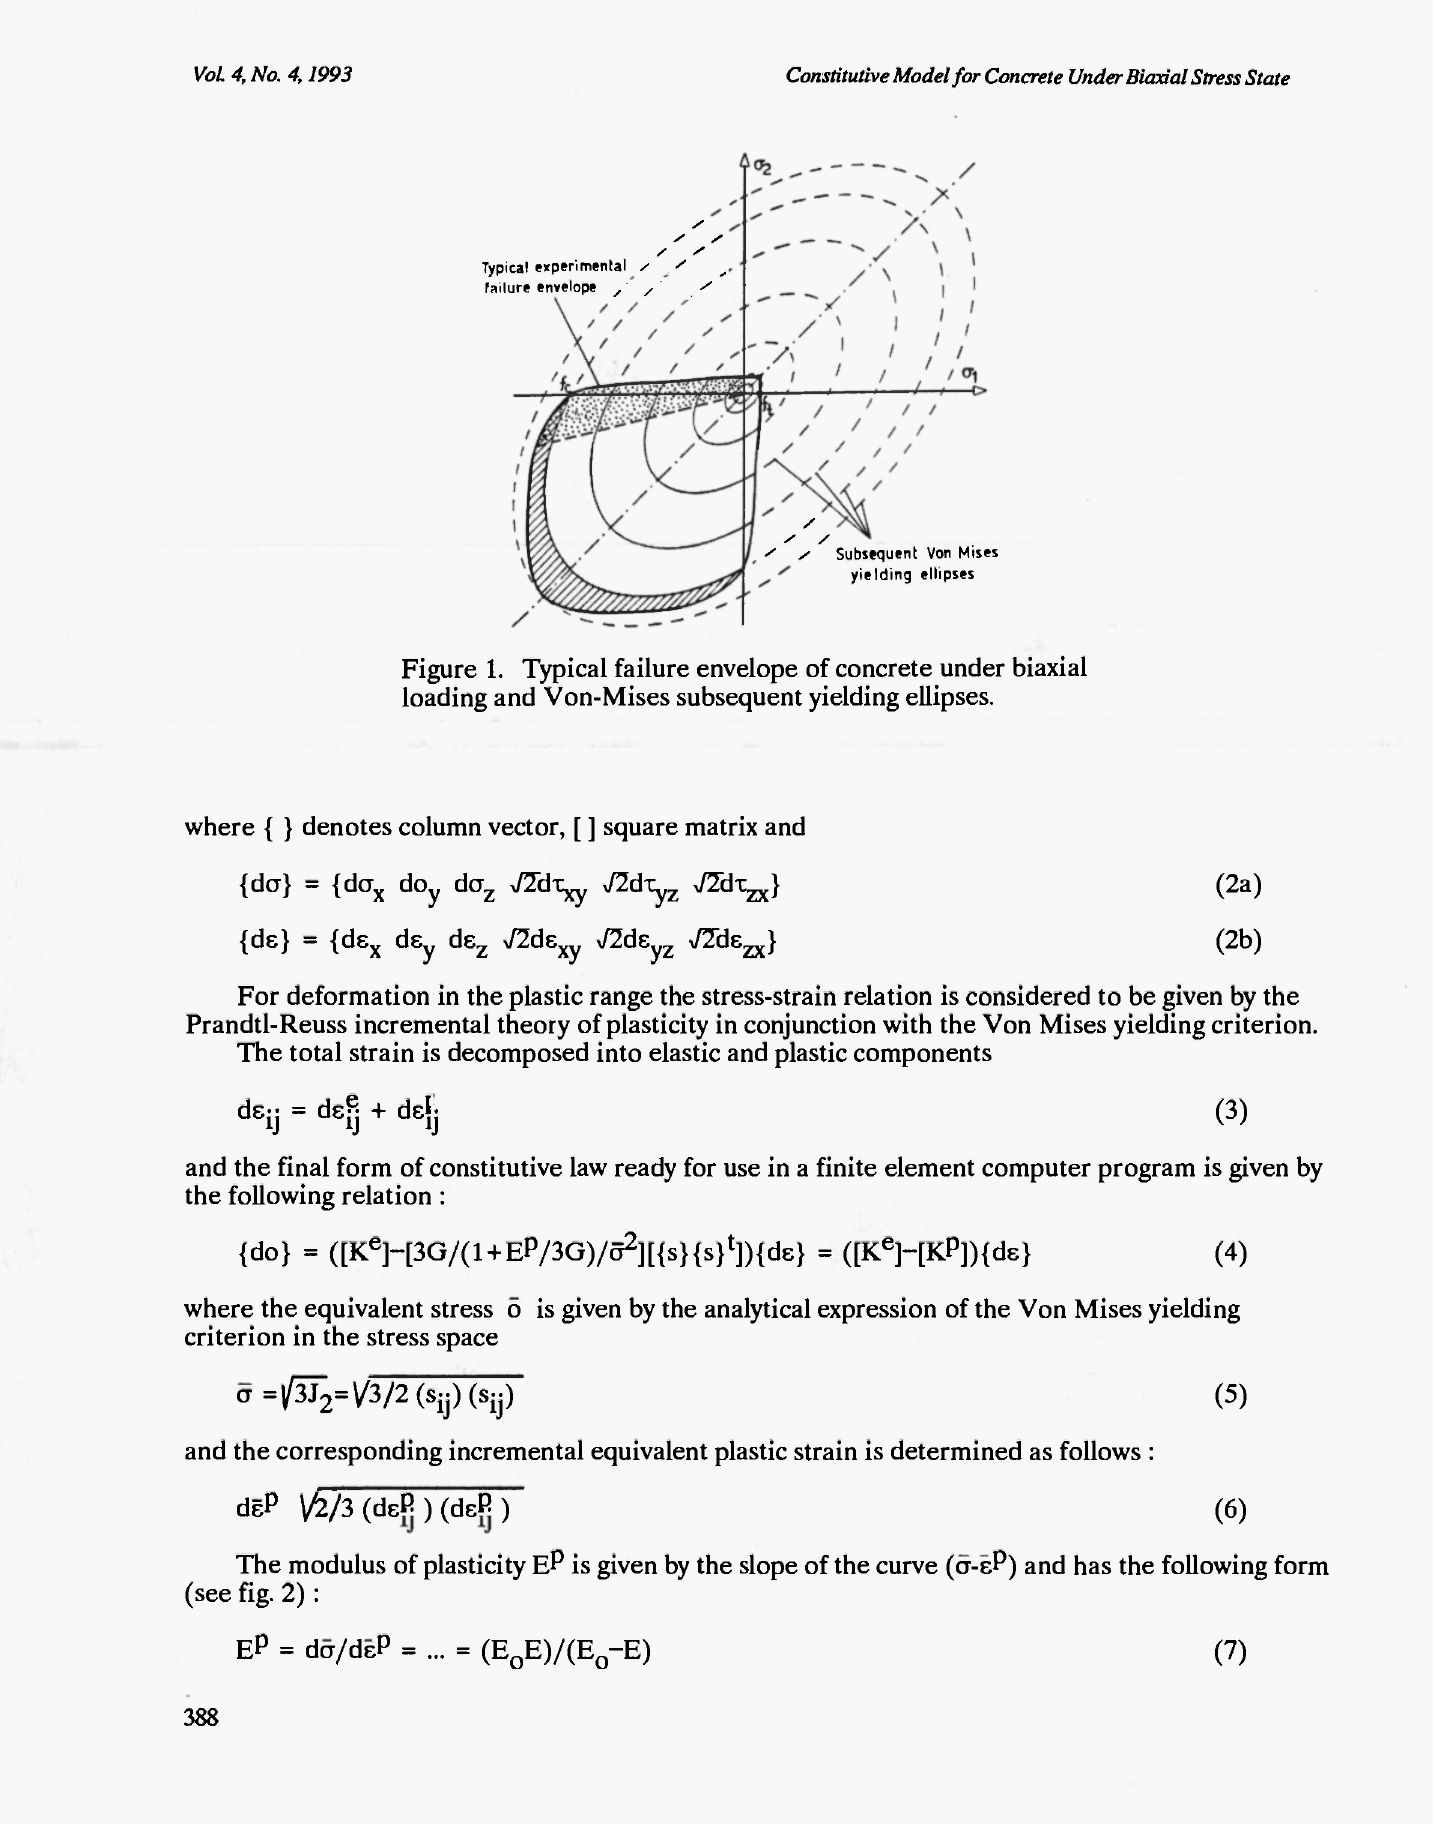
Figure 1. Typical failure envelope of concrete under biaxial loading and Von-Mises subsequent yielding